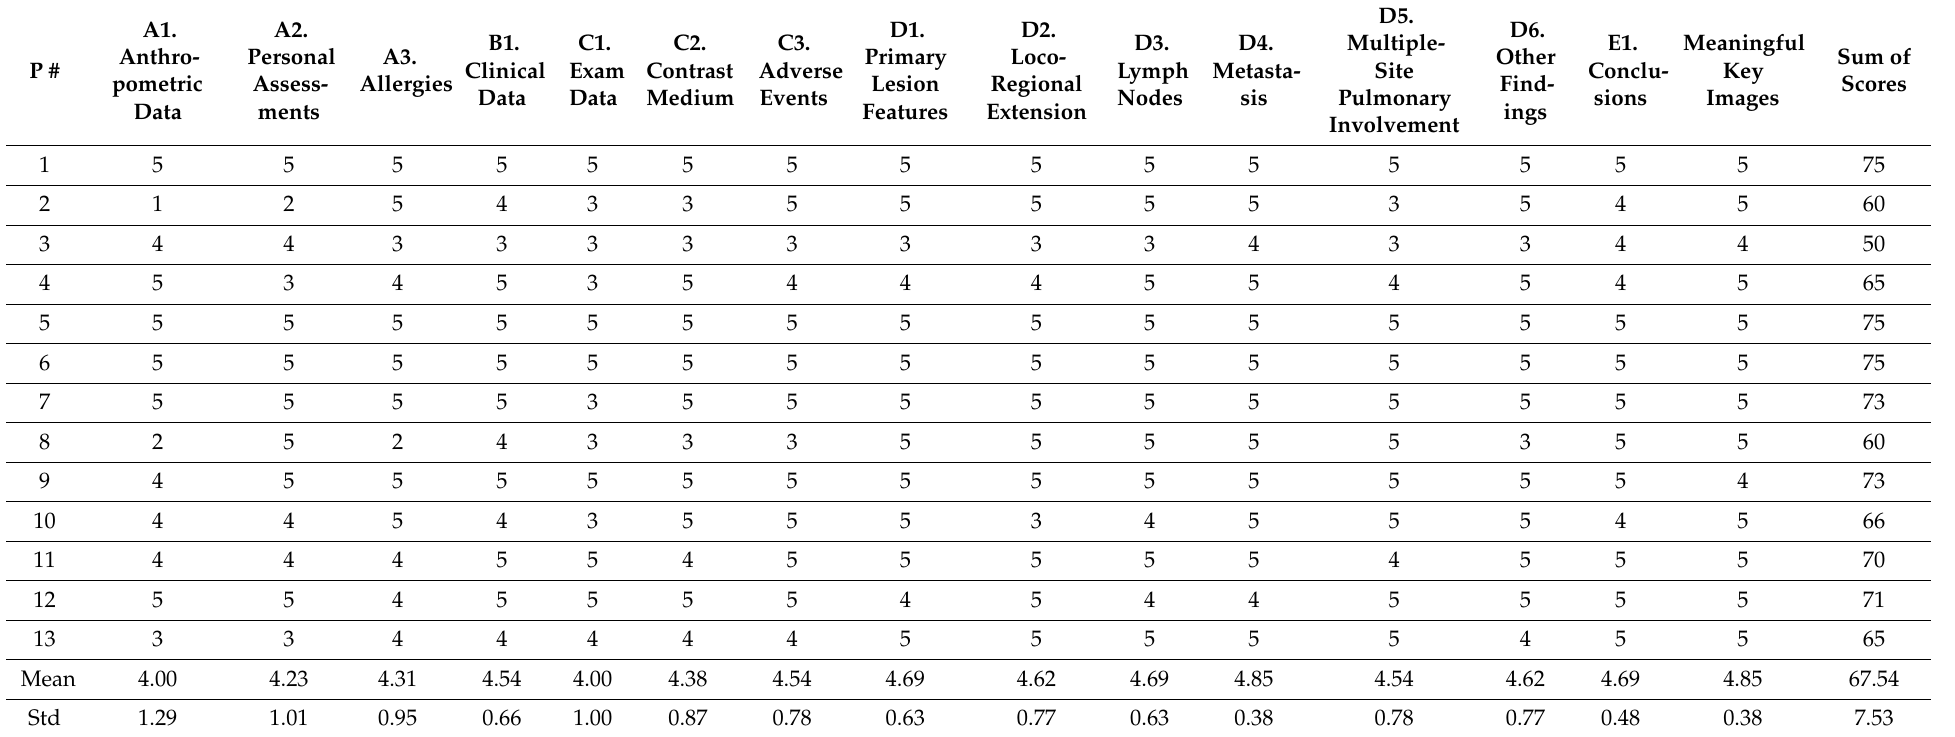
Table 1. Single scores and the sums of scores of panelists for staging in the SR (round